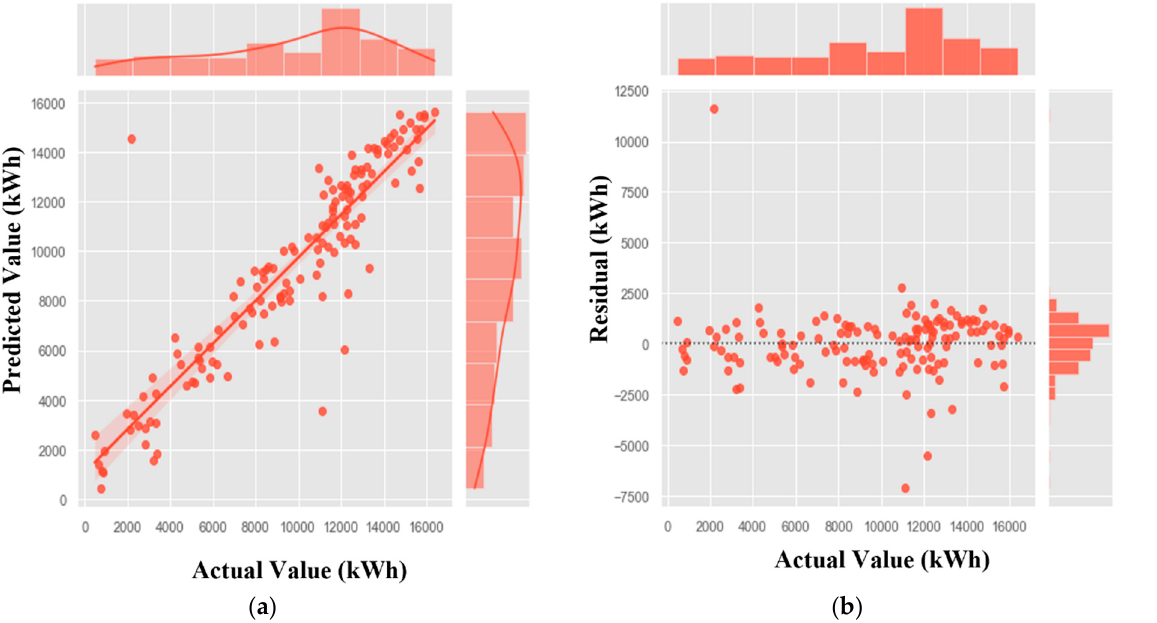
Figure 8. Jointplot of the MLP-based Electricity Usage Prediction Model: ( a ) Regplot (the solid line represents the regression line), and ( b ) Residplot (the dotted line represents the regression line). A sloping regression line is displayed horizontally to visualize how far the values depart from the regression line, i.e., how accurate the regression line is. In Residplot, values close to the regression line converge to 0. When electricity consumption was predicted using SVR, a CvRMSE value of 21.59% and R 2 value of 0.72 were obtained for the linear kernel; a CvRMSE value of 20.52% and R 2 value of 0.75 for the RBF kernel; and a CvRMSE value of 22.10% and R 2 value of 0.71 for the polynomial kernel. The RBF kernel exhibited the highest accuracy among the three SVR kernels.